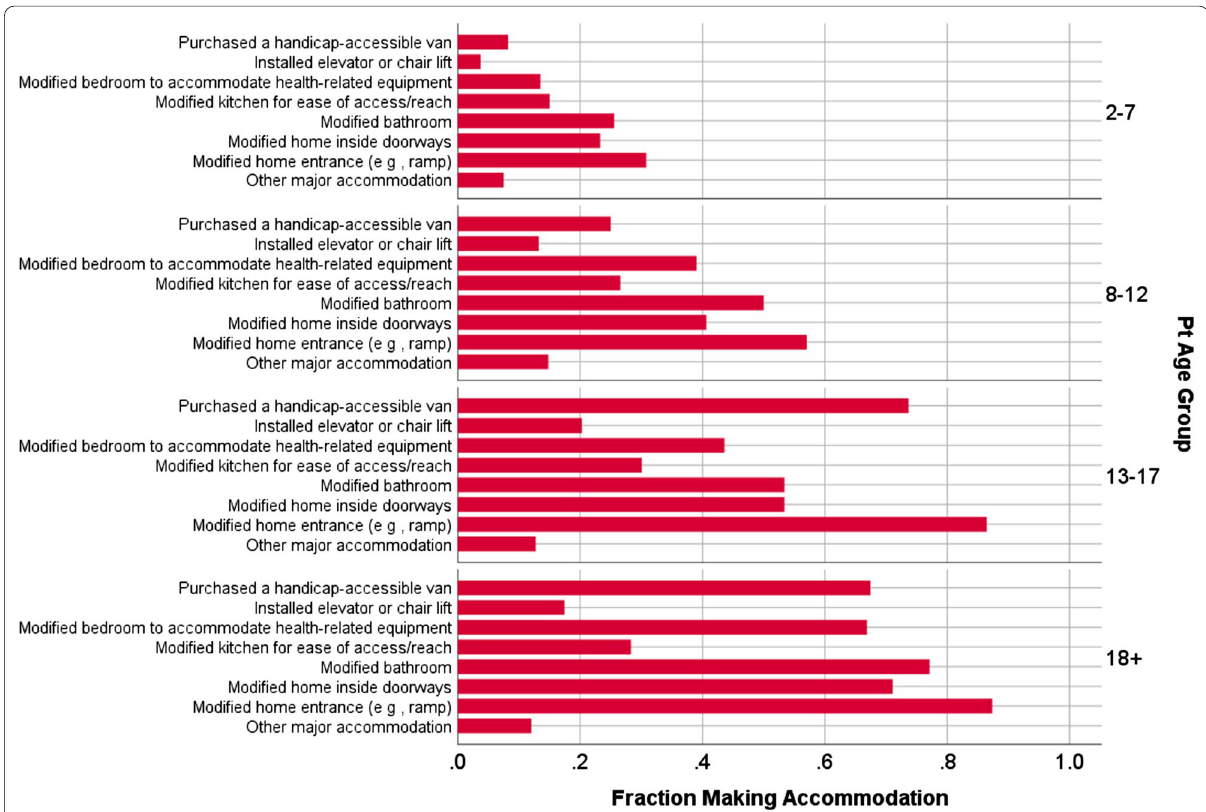
these met Cohen’s [60] criterion for “small” effect size; Table 3). There were no Group differences on resilience or life stress in these covariate-adjusted models.